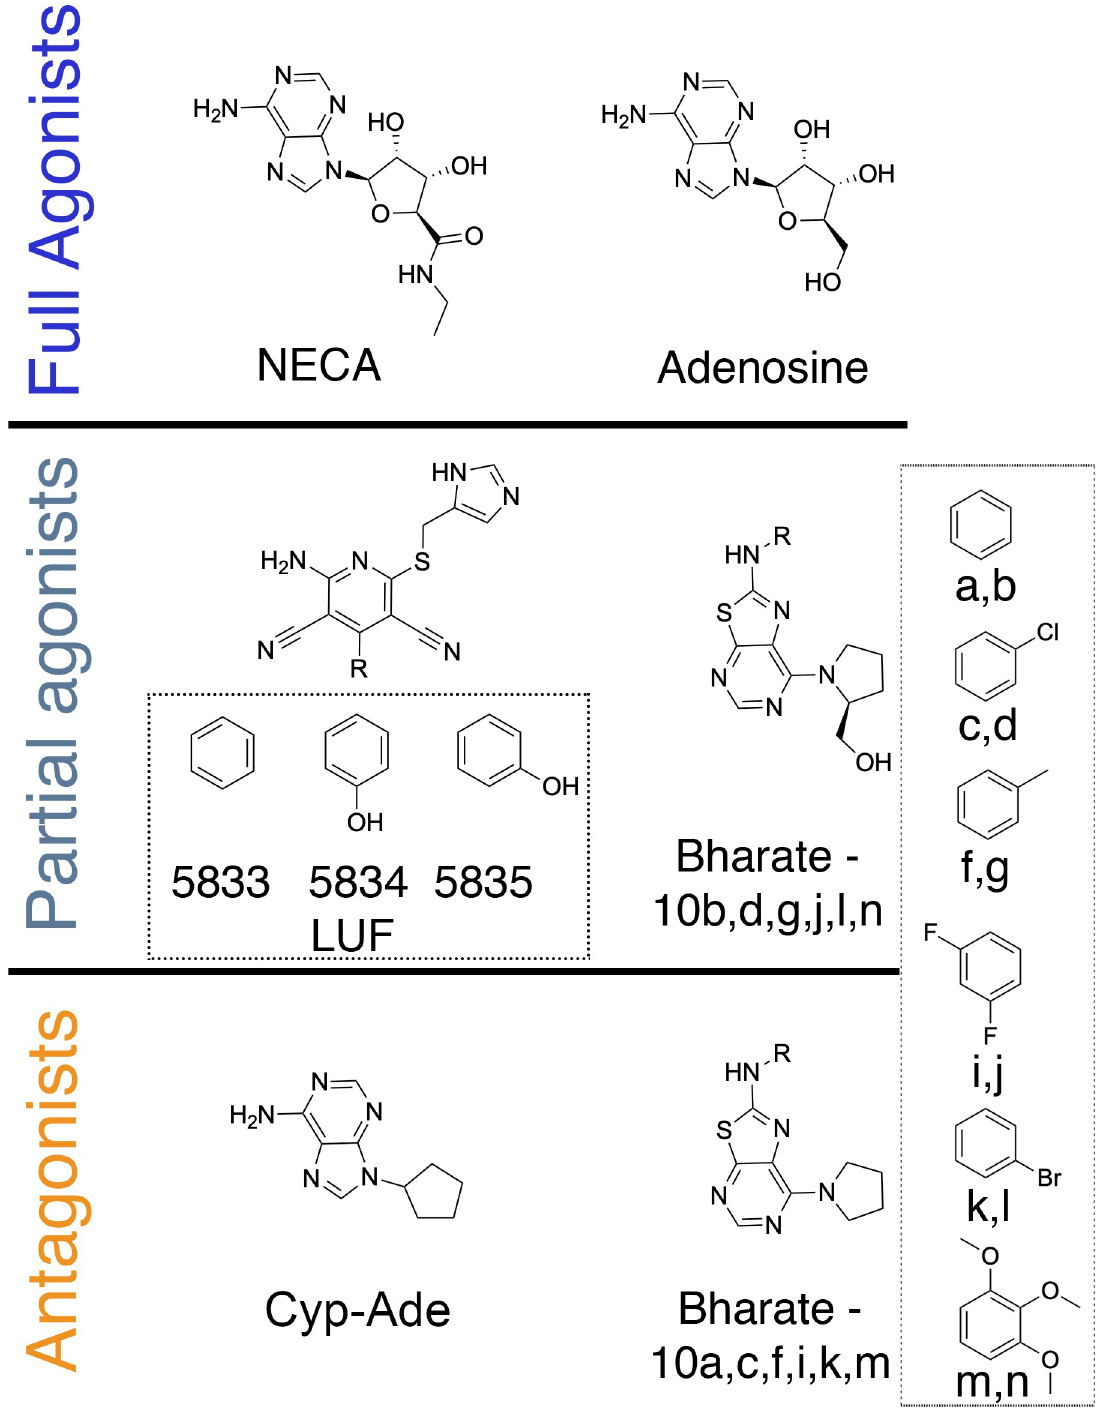
Fig 2. Chemical structures of the compounds considered in this work, classified according to their experimental pharmacological profile.